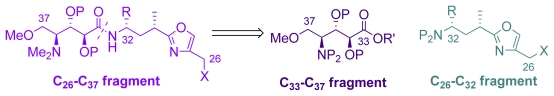
Retrosynthetic analysis of the C26–C37 fragment (X denotes the functional group suitable for coupling with the fragment C9–C25).